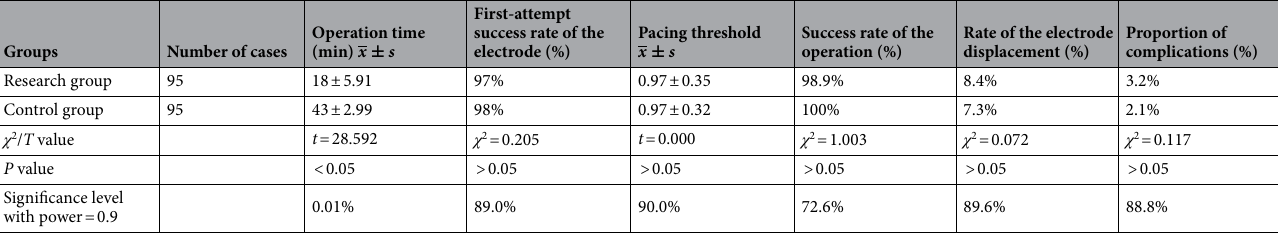
Table 1. Comparison of observation